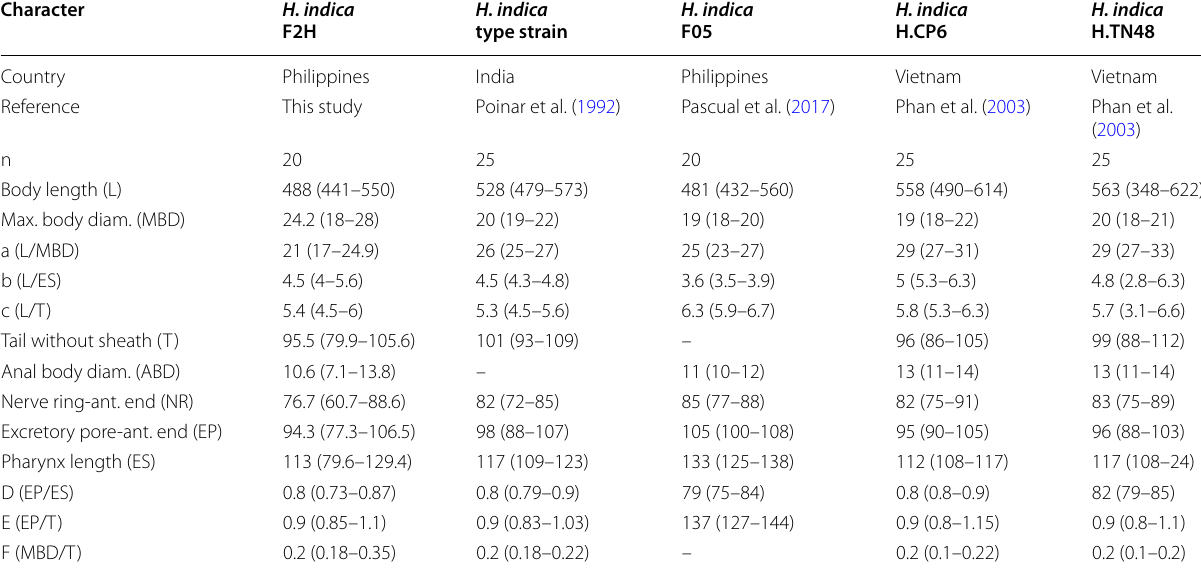
All morphometric measurements are in µm (except n, ratio and percentage) and expressed as means